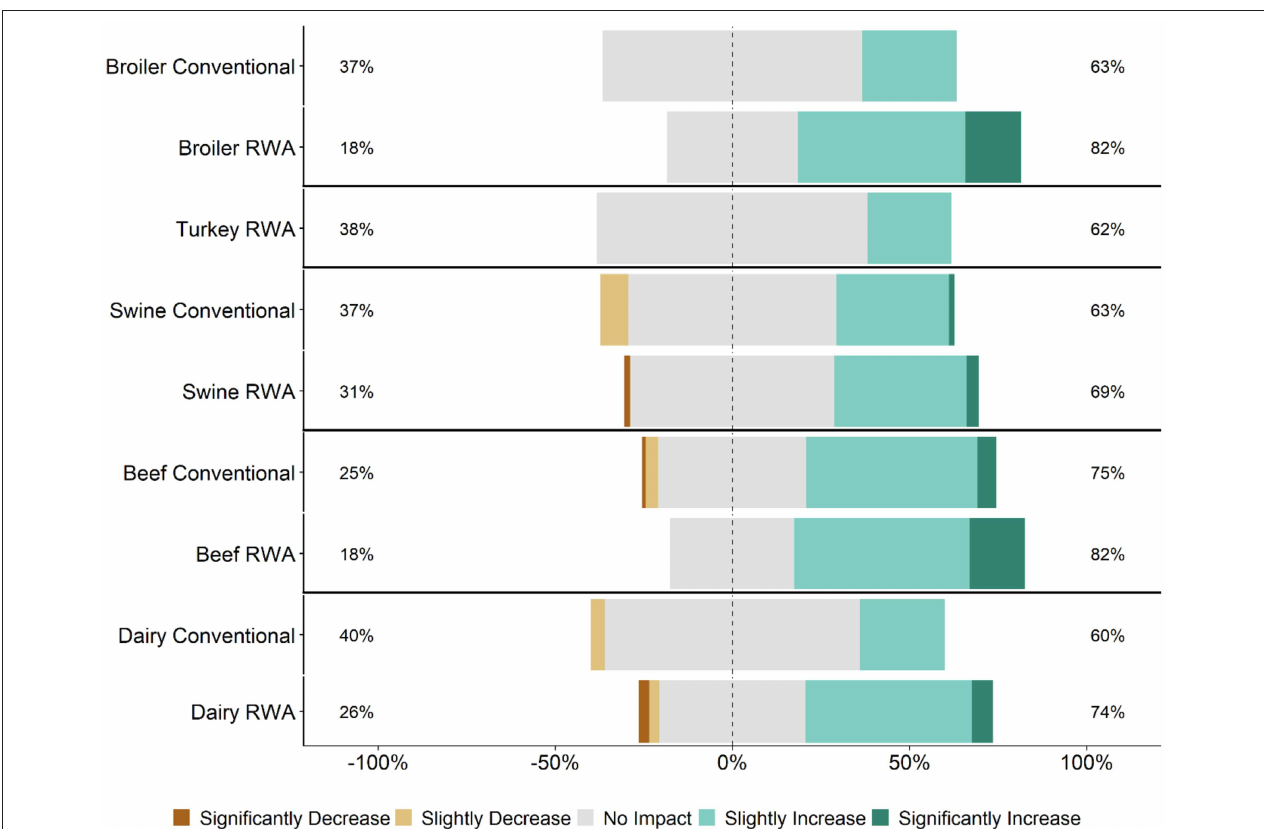
FIGURE 6 | Respondents’ opinion about the impact of RWA production on demand for their commodity’s protein or product. Five-item Likert scale reporting respondents’ opinion, stratified by commodity and RWA experience.